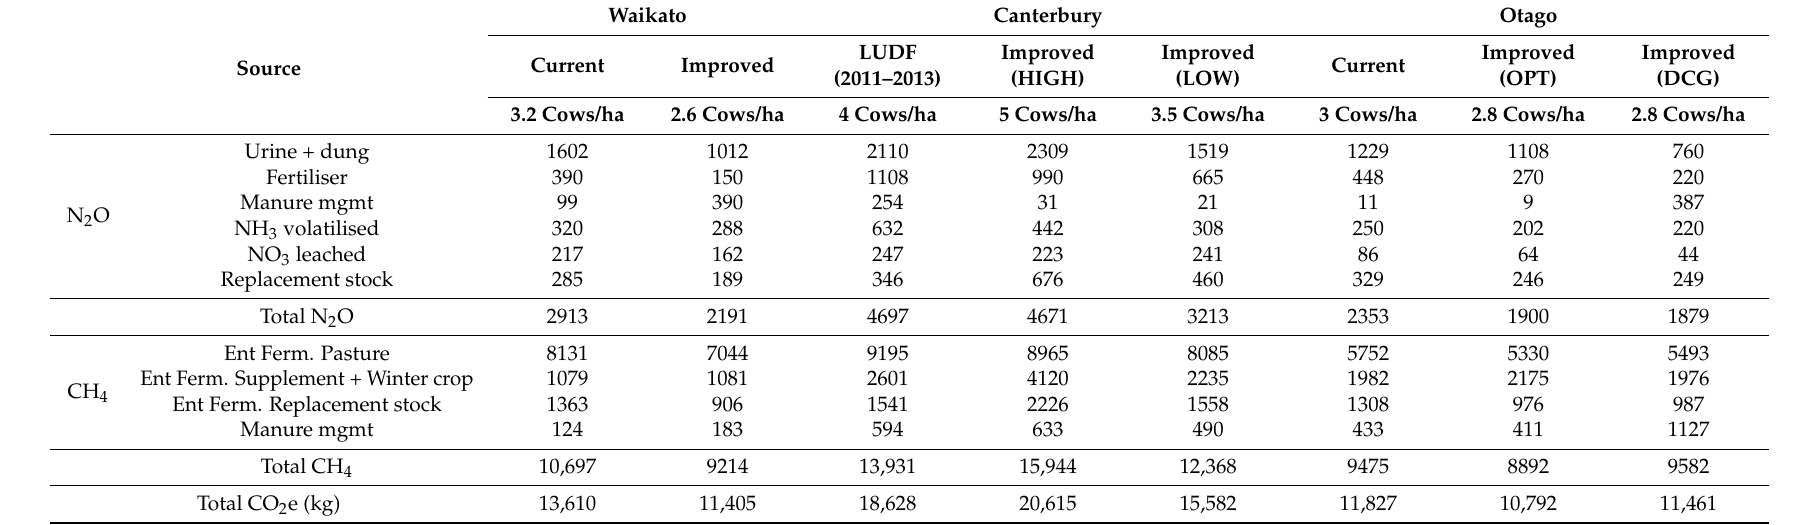
Table 3. Total emissions (kg carbon dioxide equivalents per hectare of the milking platform (kg CO 2 e/ha MP) calculated for nitrous oxide (N 2 O) and methane (CH 4 ) for improved farm systems tested on small-scale farms in three regions in New Zealand (Waikato, Canterbury, and Otago). HIGH and LOW = high and low stocking rate; OPT = optimised feeding and DCG = duration controlled grazing. See text for further descriptions of each systems. Note: may not sum to total due to